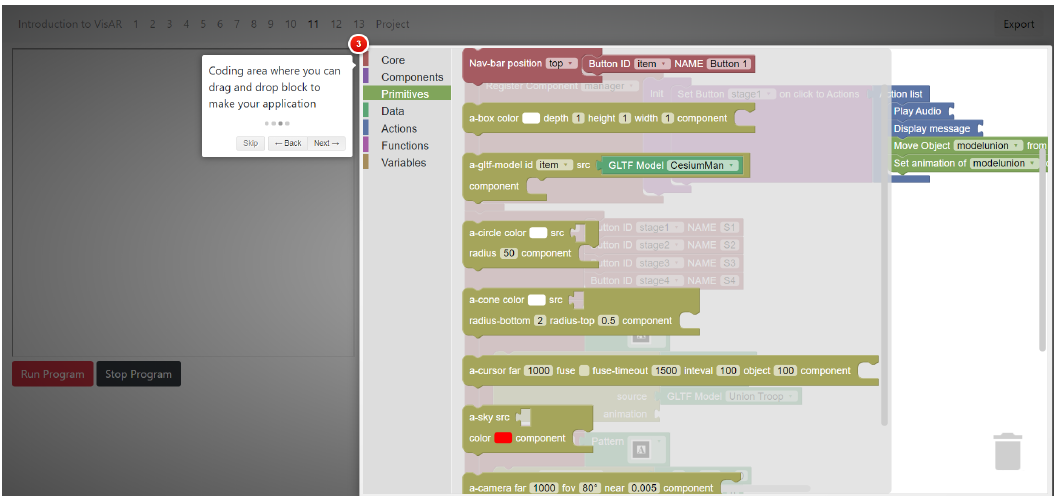
Figure 2. The coding editor of BlocklyAR enables users to drag and drop a palette of commands into the working